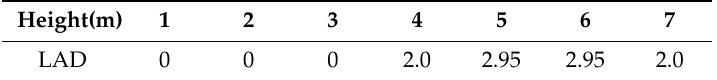
Figure 7. Schematic of grass database model for ENVI-met. The initial input data of the various meteorological elements used in the ENVI-met simulation are shown in Table 5 . In this study, the whole simulation was conducted over a 48-h period, starting from midnight 00:00 on 30 July 2016, with calculations every 1 min. The simulation results were output on an hourly basis. The simulated model in ENVI-met is shown in Figure 8.